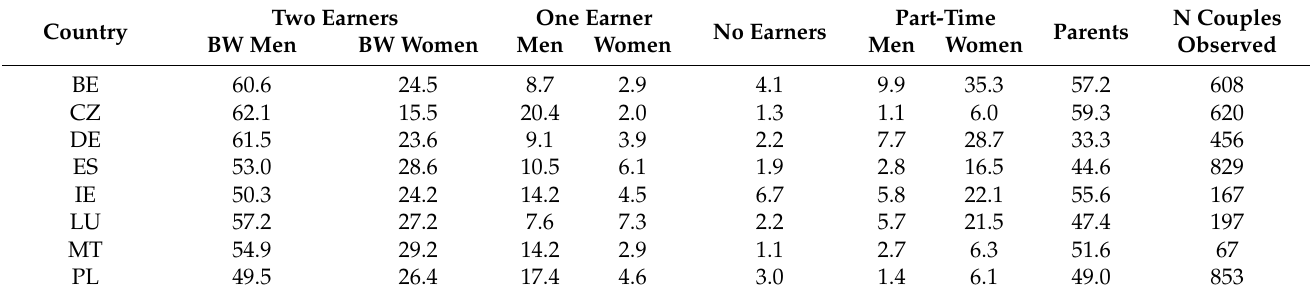
Table 3. Summary statistics of the labour market characteristics of cohabiting couples of working age (in